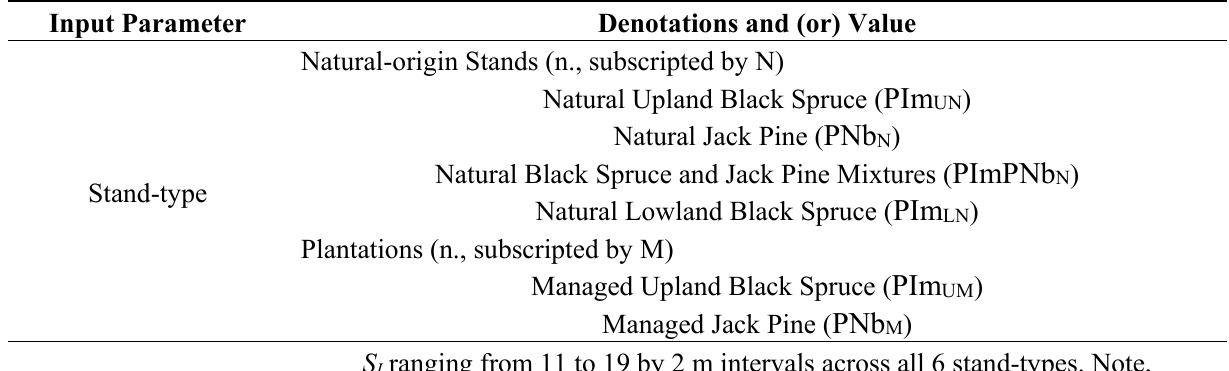
Table 1. Parameter settings and conditions for the SSDMMs